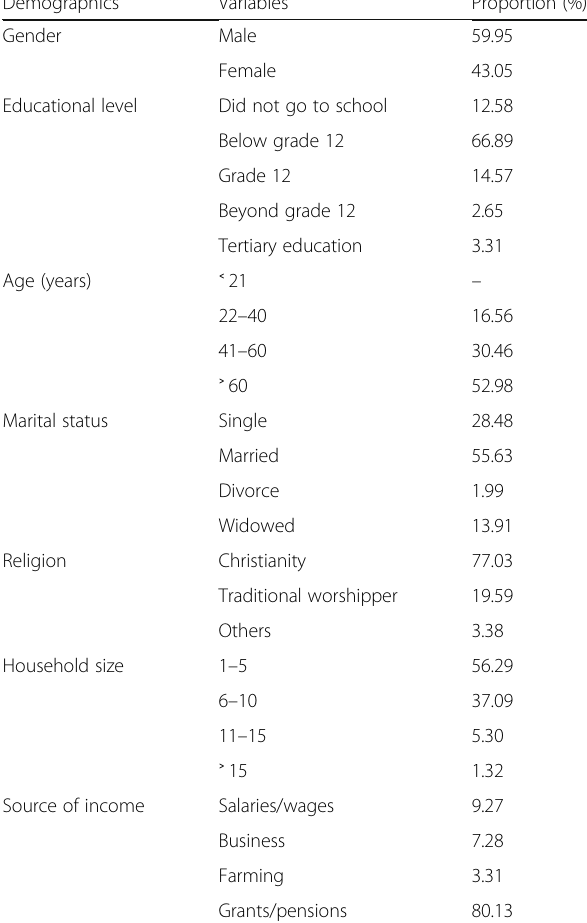
households that participated in the survey where they were asked, ‘ if they will be willing to consume goat milk and their products